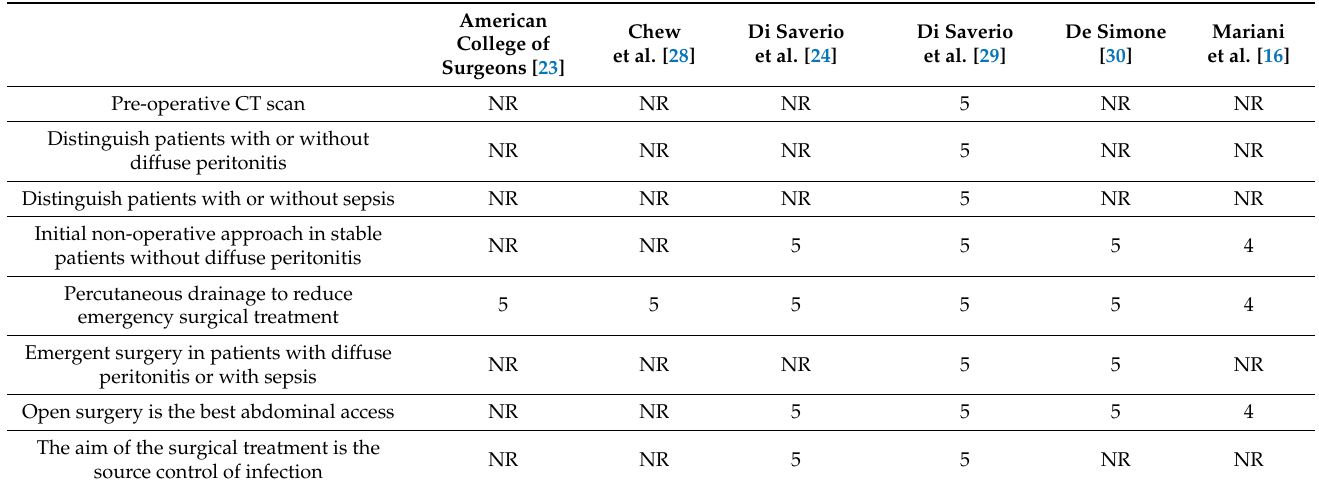
Table 6. Decision making for complicated diverticulitis during the COVID-19 pandemic. American College of Surgeons [23]